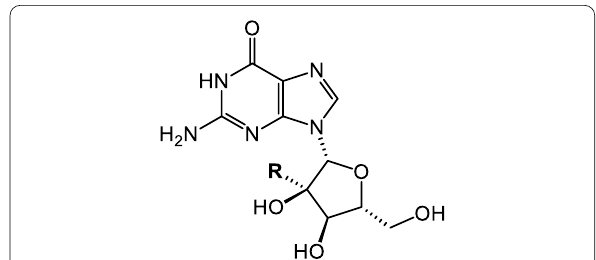
Fig. 1 The structure of HCV NS5B enzyme in interaction with Sofosbuvir